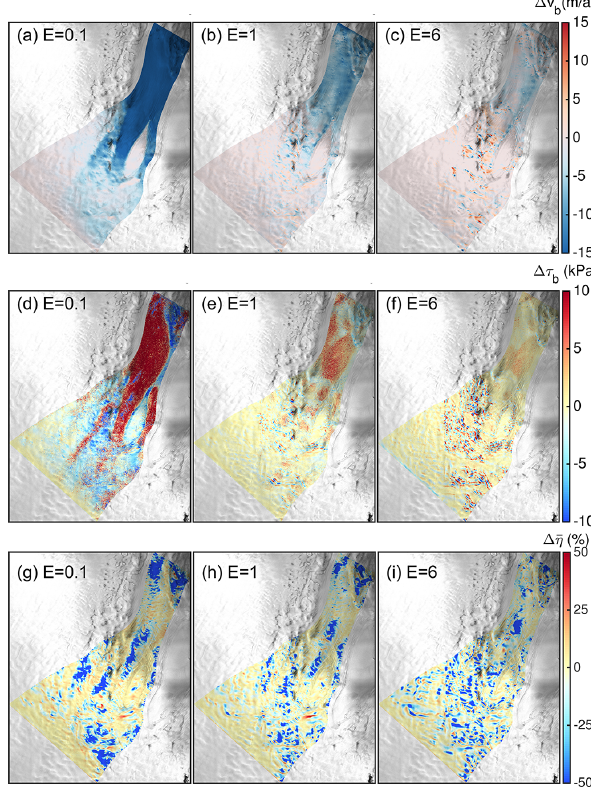
Figure 11. Comparison of characteristic quantities for a resolu- tion of l = 100m, m = 1 and P1P1GLS strong at the ice-stream domain. Difference (FS minus BP-like solution) of basal veloci- ties v b (a–c) and basal drag τ b (d–f) . Relative difference of depth- averaged viscosity ¯ η (g–i) between FS and BP-like. The domain- averaged mean viscosity for FS and E = 0 . 1, 1 and 6 are 10.8, 3.6 and 1 . 1 × 10 14 Pas, respectively; for BP-like they are 12.6, 4.1 and 1 . 3 × 10 14 Pas, respectively. The equivalent fields for E = 3 reveal patterns and magnitudes that range from E = 1 to E = 6. Back- ground image is a RADARSAT Mosaic (Joughin, 2015; Joughin et al.,